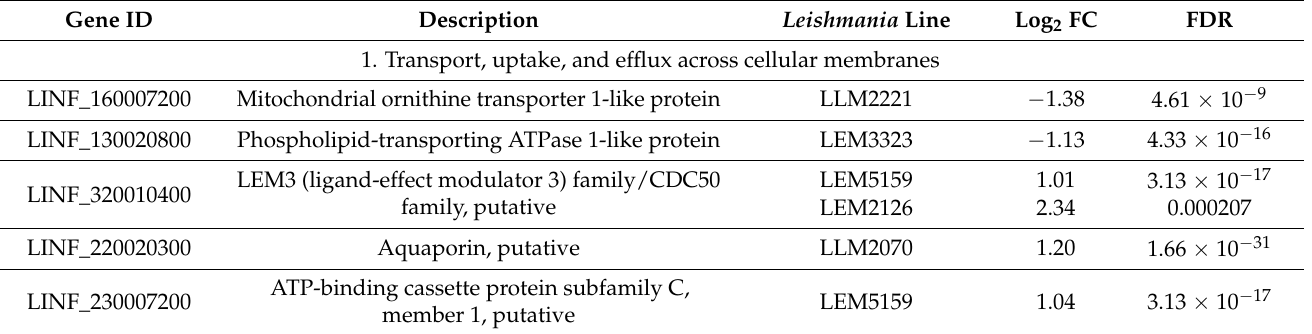
ATP-binding cassette protein subfamily C, member 1,